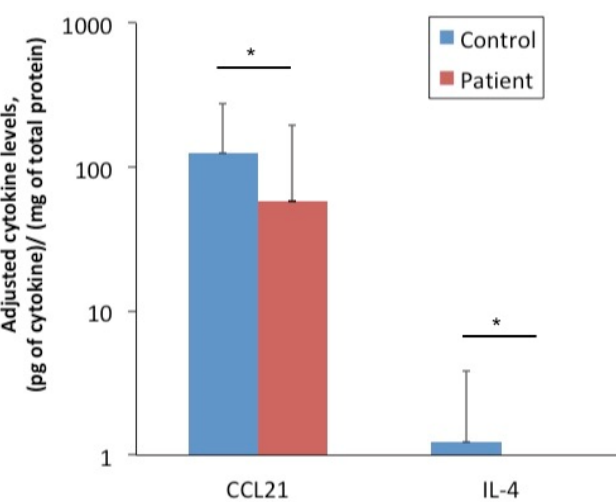
Figure 4. Comparison of cytokine levels in the tear fluid of radiated head and neck cancer patients and controls. Multiplex assay of the cytokine levels in tear fluid reveal significantly lower levels of both CCL21 and IL-4 in the patient group as compared to the controls. Other cytokine levels do not show statistically significant differences between patients and controls. * represents p < 0.05.